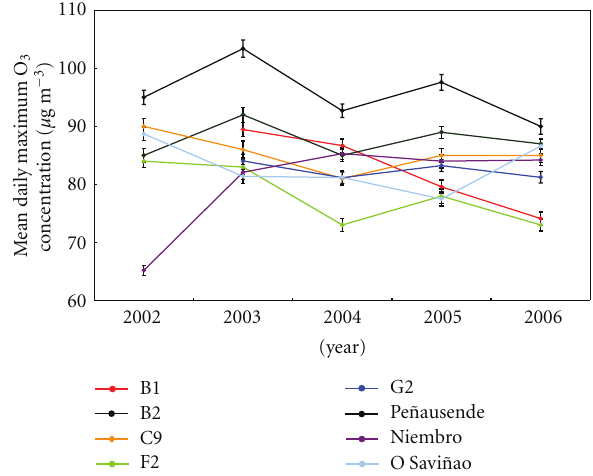
Figure 6: Series of annual mean of daily maximum ozone concen- trations throughout the 5-year-study period (2002–2006) for each